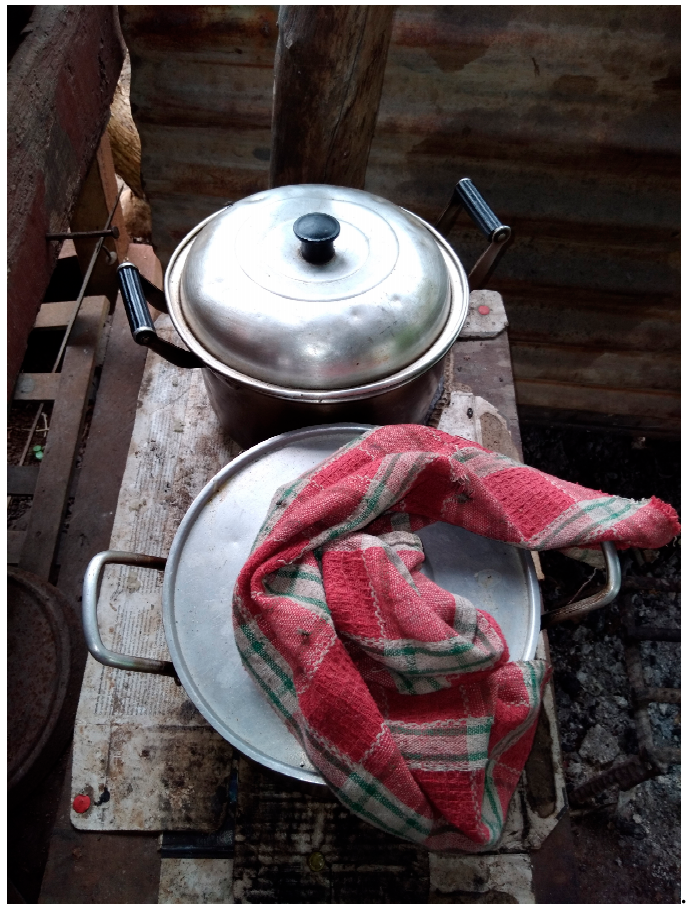
Figure 1. Unable to generate an income. Photo caption: She prefers to wear disposable pads now but needs money for that. She wants to be able to earn money from selling food, but she struggles to cook food in order to earn money. Photo credit: Tony.